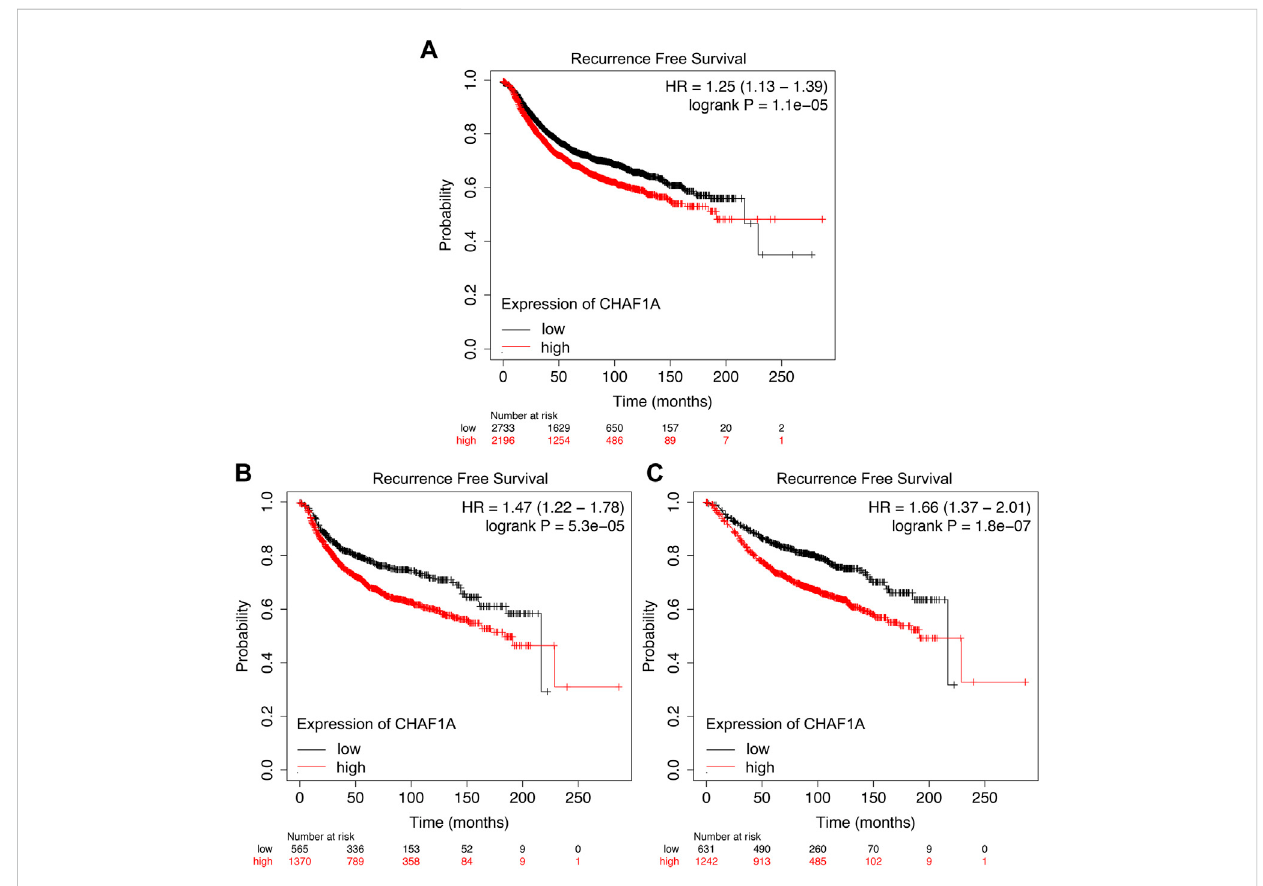
FIGURE 5 Resistance to endocrine therapy and chemotherapy treatment of breast cancer patients correlated with elevated CHAF1A expression as found by Kaplan-MeierPlotter.BreastcancerpatientswithelevatedexpressionofCHAF1Ashowedshortertimetodevelopdiseaserecurrencewhentheyreceived (A) chemotherapy and endocrine therapy, (B) chemotherapy treatment, and (C) endocrine therapy treatment as found by Kaplan-Meier Plotter